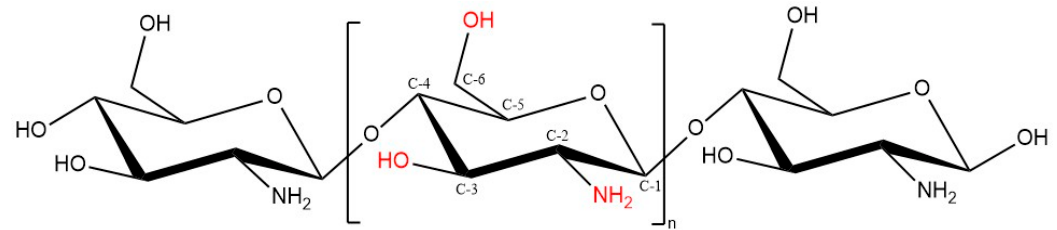
Figure 4. Chitosan chemical structure (DD ≥ 50%).